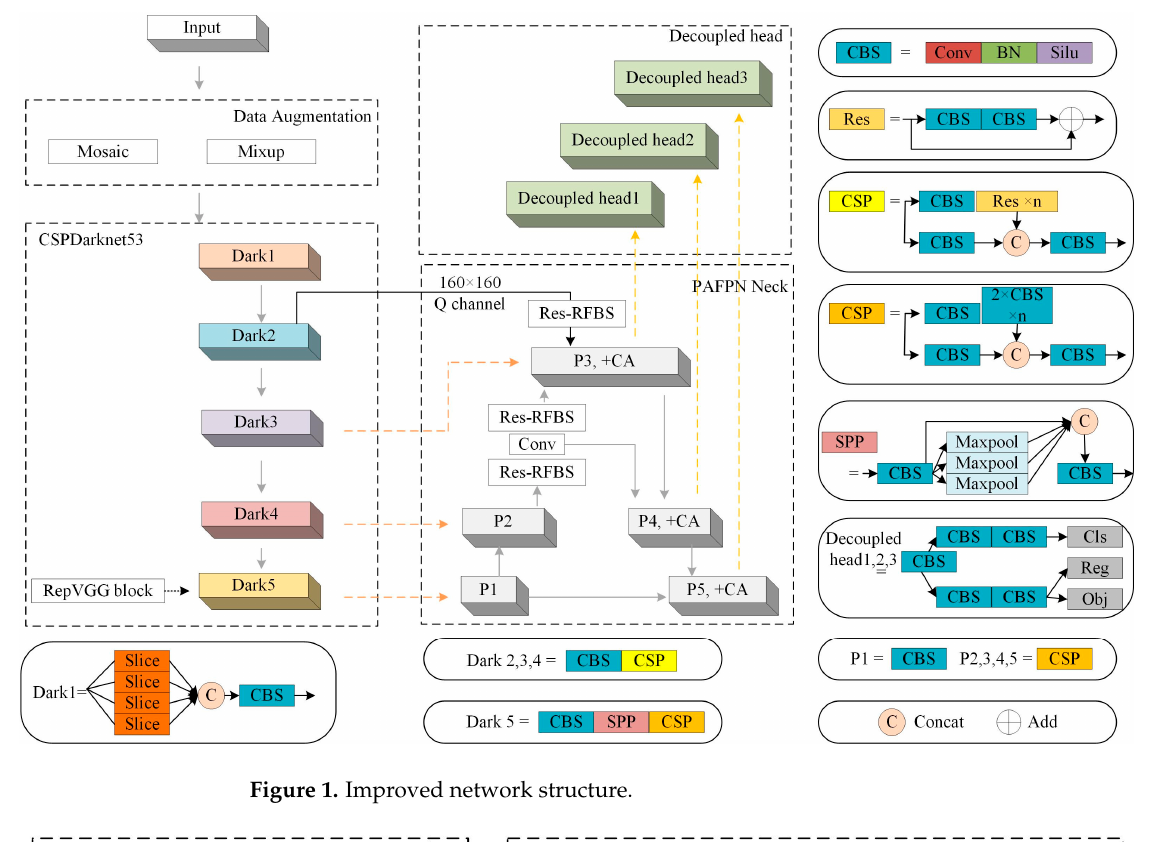
Figure 1. Improved network structure.